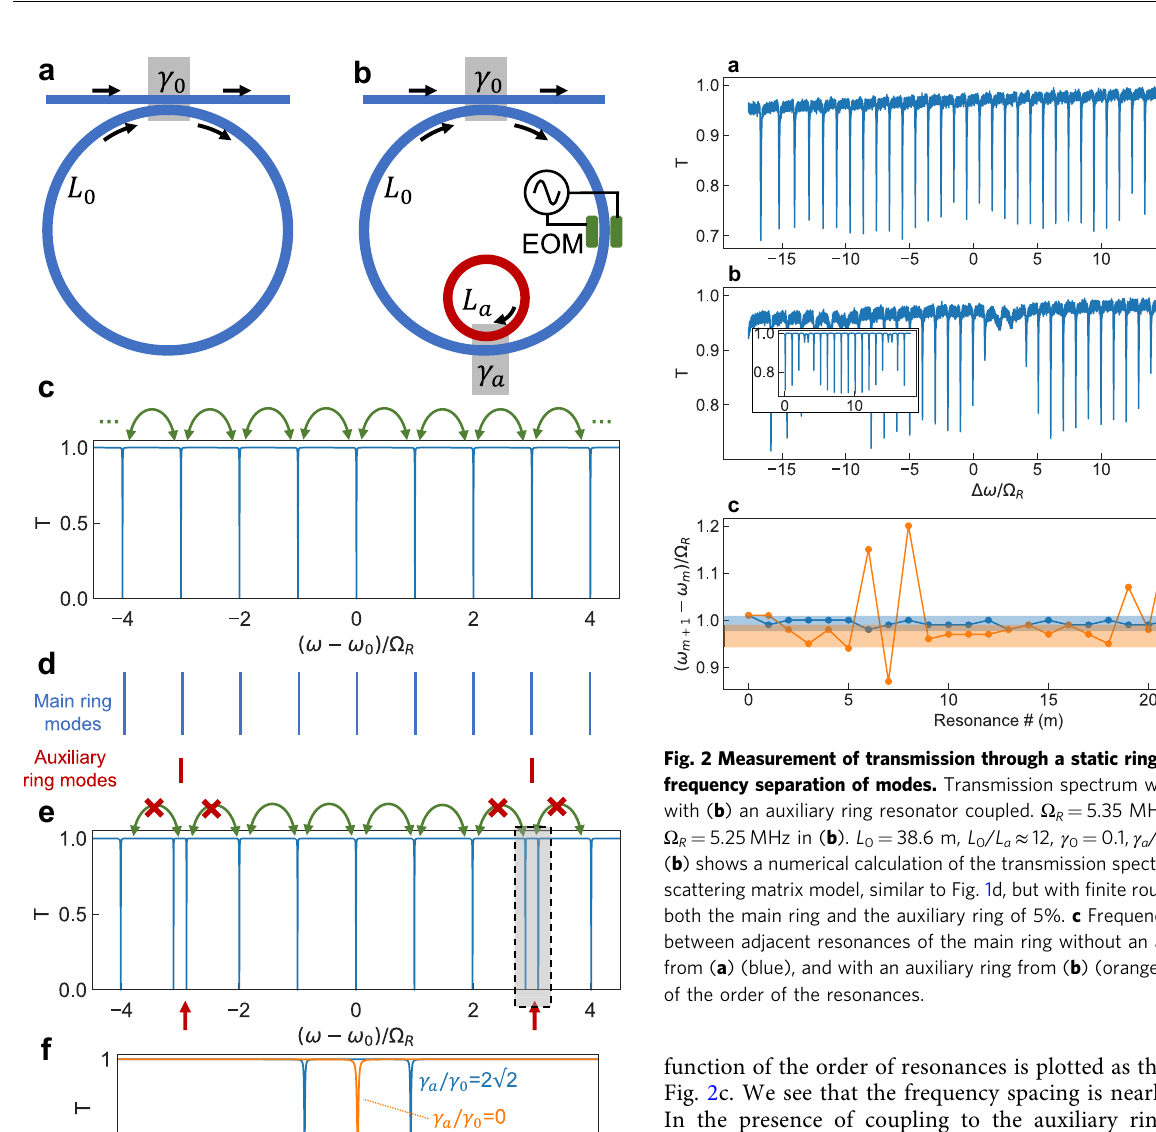
function of the order of resonances is plotted as the blue line in Fig. 2c. We see that the frequency spacing is nearly a constant. In the presence of coupling to the auxiliary ring, there is a marked increase in T near the main cavity modes that are min aligned to the auxiliary ring modes (Fig. 2b). The increase in T is in accordance with scattering matrix simulations min including a loss in the auxiliary ring (inset of Fig. 2b), and this loss was ignored in Fig. 1d, e for simplicity. Around the reso- nant frequencies of the auxiliary ring, we see that the reso- nances of the coupled system are no longer equally spaced (orange line in Fig. 2c). In addition, for the coupled system, the frequency spacings between modes far away from the reso- nances of the auxiliary ring, which we de fi ne as the FSR of our coupled ring system, is smaller as compared to the FSR of the main ring by itself (Fig. 2c, see Supplementary Section II for an ¼ 0 : 01. For analytical derivation of this effect). 0 ¼ 0 : 99. The 0